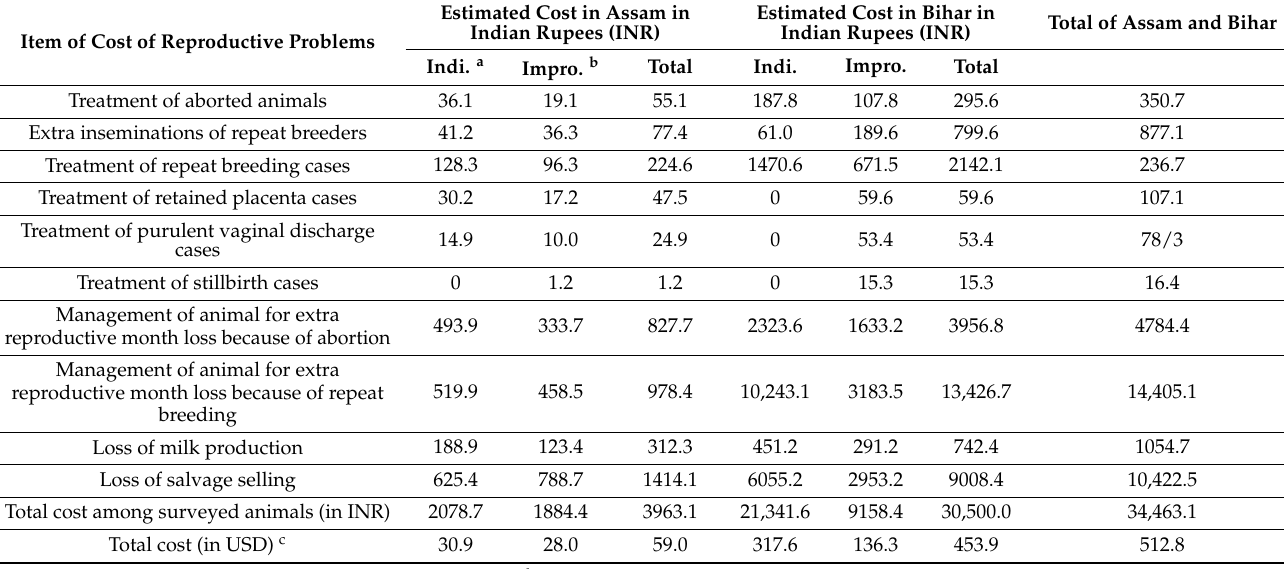
Table 5. Estimated cost of selected reproductive problems in the states of Assam and Bihar (all figures are in Million). Estimated Cost in Assam in Estimated Cost in Bihar in Indian Rupees (INR) Indian Rupees (INR) Total of Assam and Bihar Item of Cost of Reproductive Problems Indi. a Impro. b Total Indi. Impro.